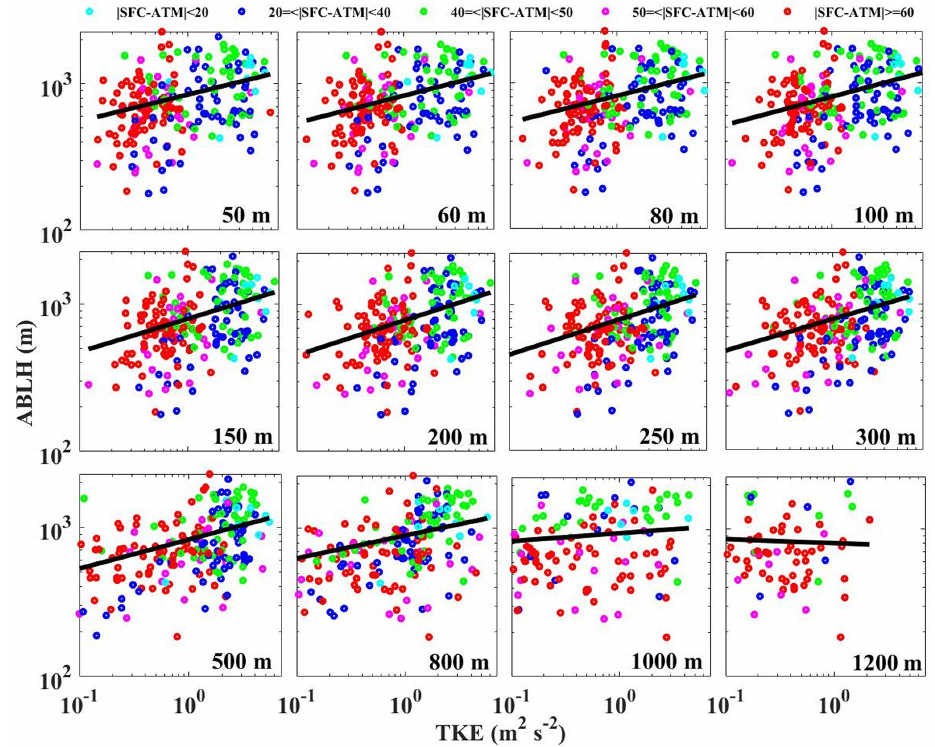
Figure 7. The atmospheric-boundary-layer height (ABLH; y ) as a function of the turbulence kinetic energy (TKE; x ) at the different altitudes and the aerosol direct radiation effect defined as | SFC − ATM | (color code). The calculated hourly data used above are collected over 2 months in Beijing from 27 November 2018 to 25 January